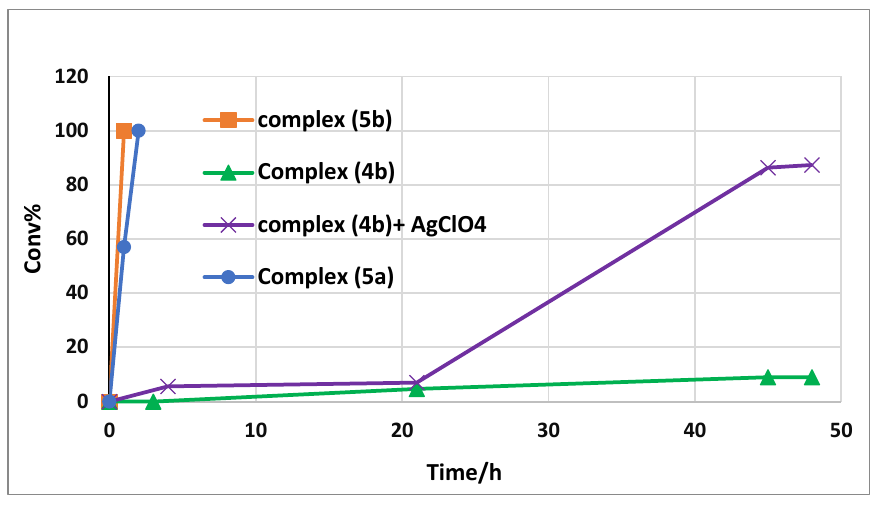
Figure 2. The conversion-time profile with different catalysts (0.5 mol%) in the hydrosilylation of PhCHO.